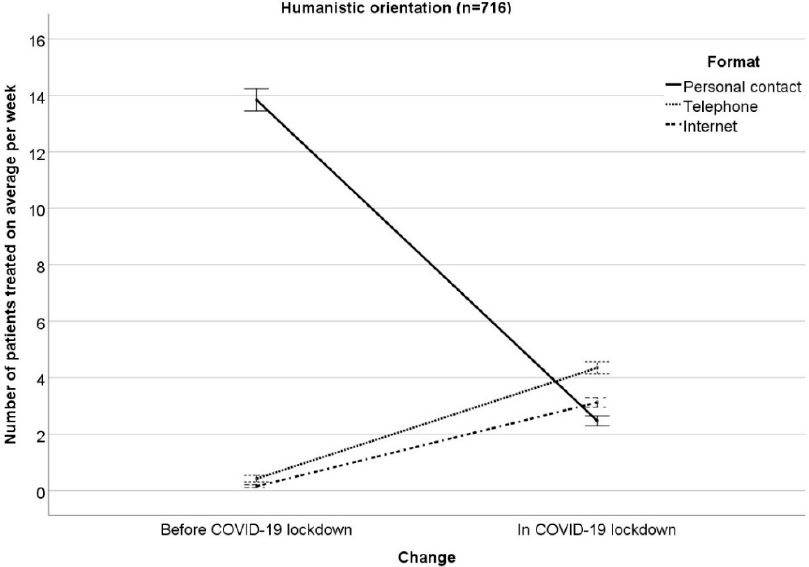
Figure 2. Number of patients treated on average per week in personal contact, via telephone, via Internet in the months before / in COVID-19 lockdown for humanistic orientation. Mean ± 1 standard error.